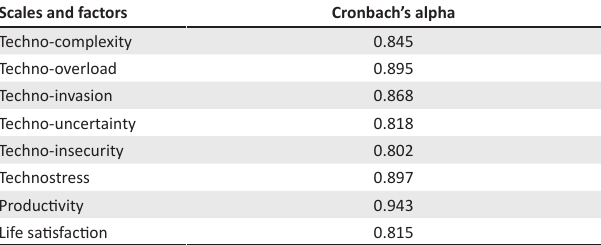
TABLE 1: Cronbach’s alphas for the scales and